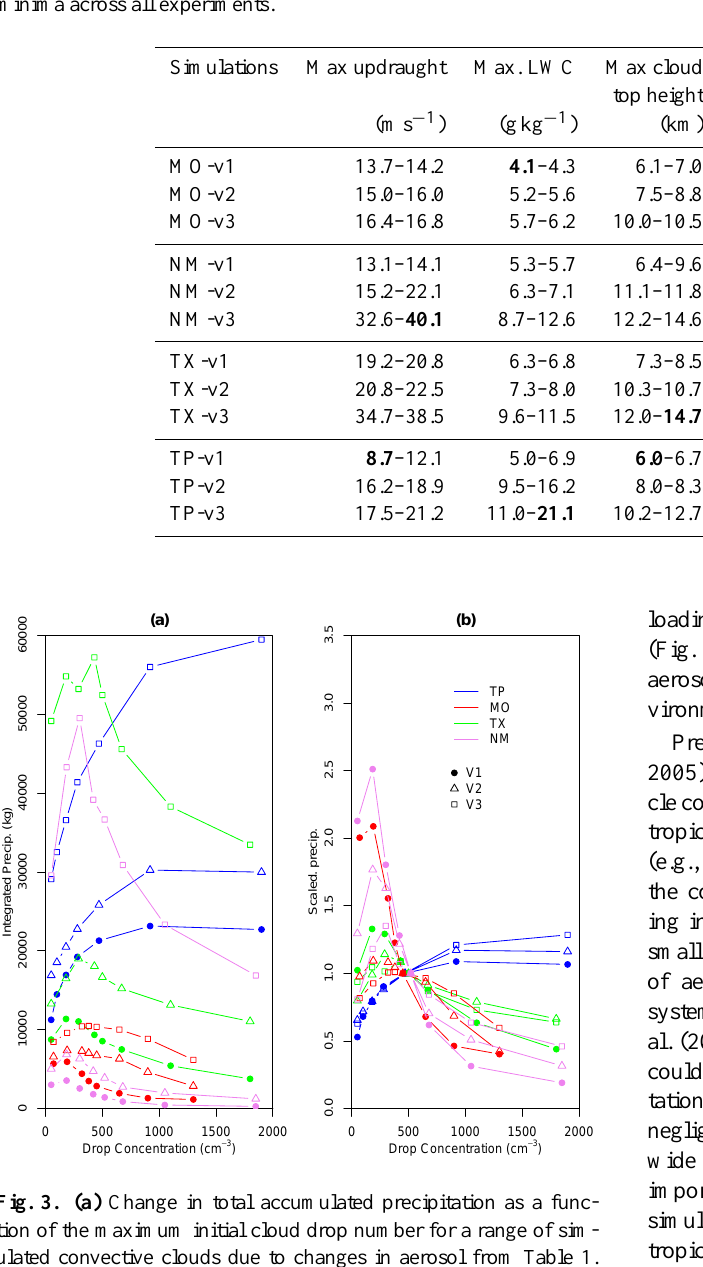
Table 3. Variation of updraught speed, liquid water content, cloud top height, accumulated and peak rainfall in the simulated clouds. The ranges show the response to changes in aerosol given in Table 1. Accumulated precipitation is area-weighted. Bold indicates maxima and minima across all experiments.